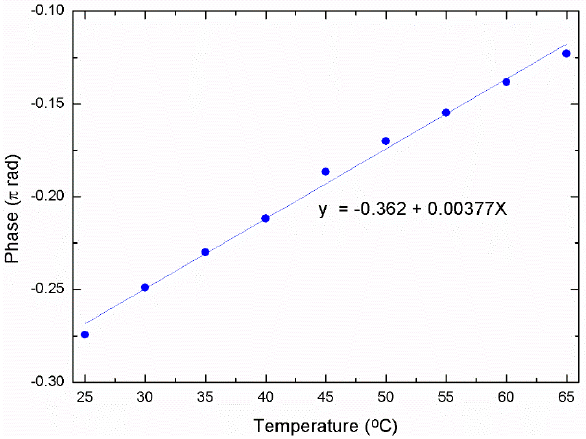
Figure 5. Optical sensor’s response towards temperature variations.